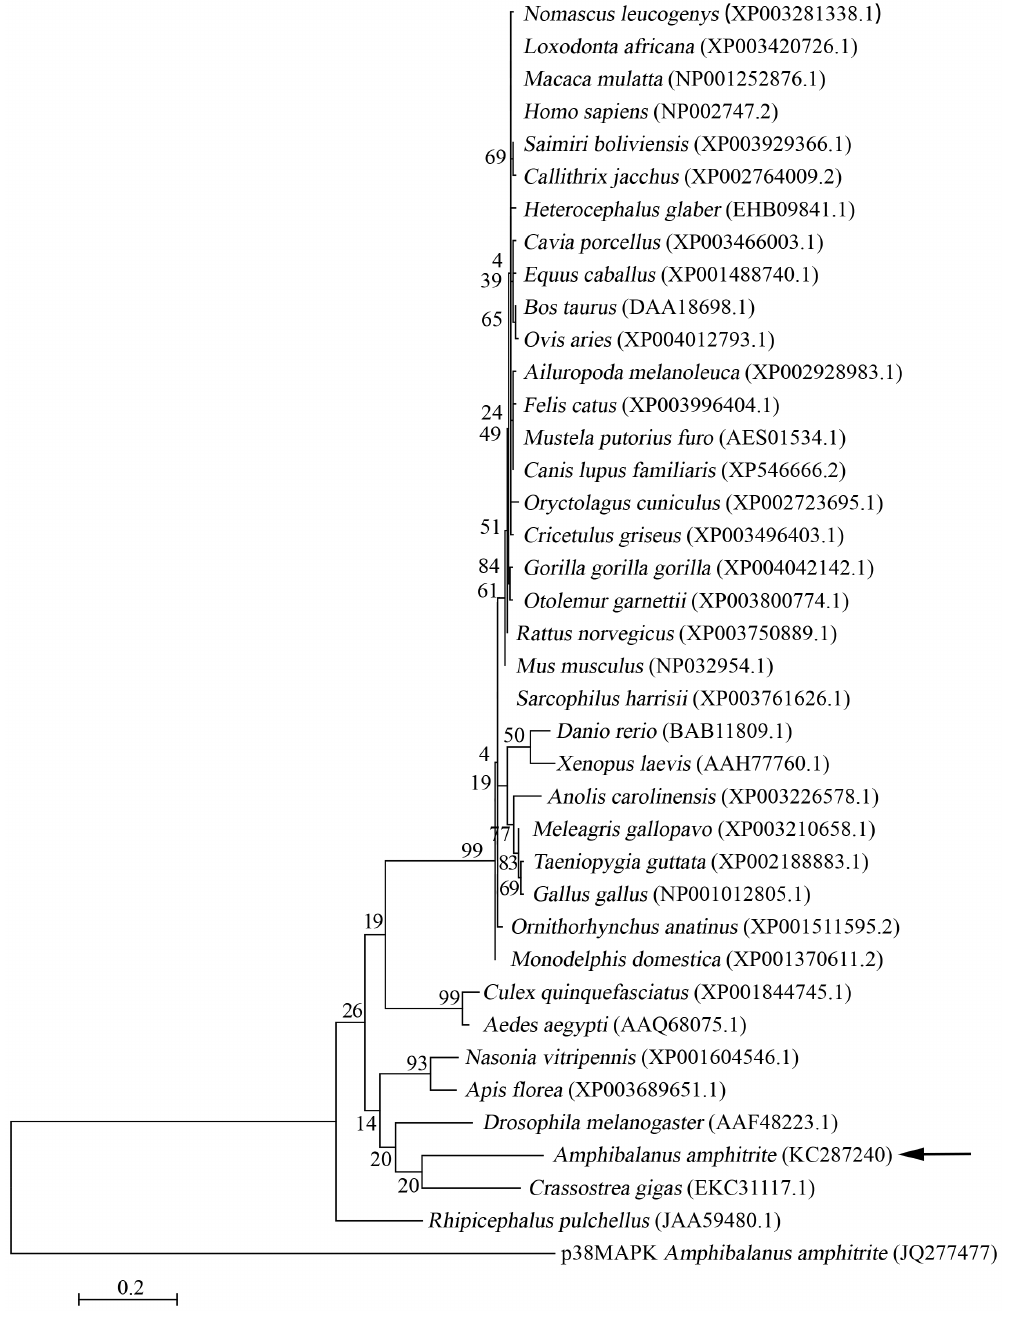
Figure 2. The phylogenetic relationship of MKK3 among different species. Maximum Likelihood (ML) tree was constructed based on the complete amino acid sequences of MKK3 from Amphibalanus amphitrite and other species. A. amphitrite p38MAPK sequence was chosen as the outgroup. Support for each node was tested with standard bootstrap analysis using 1,000 replications. The Genbank access number for each species was labeled with the species